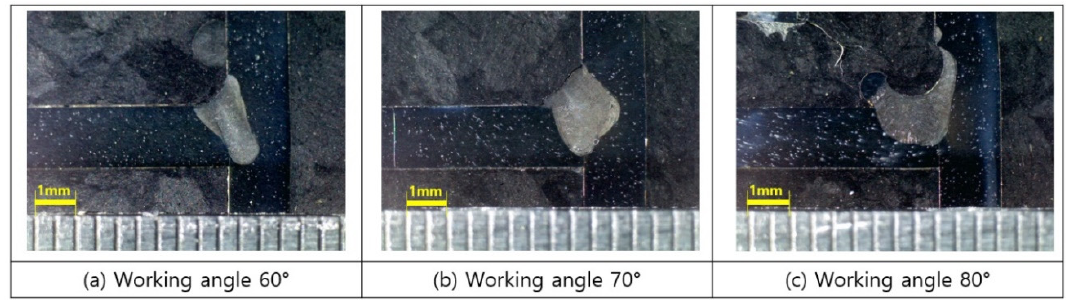
Table 5. Welding conditions of Step 1 (working angle change, 3 cases).